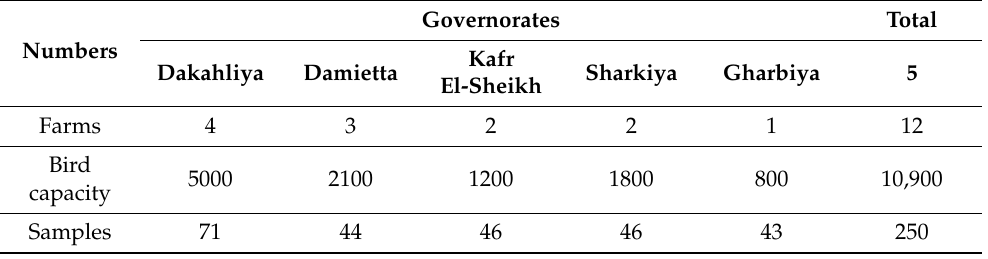
Table 1. Investigated turkey farms in northern Egypt and number of collected